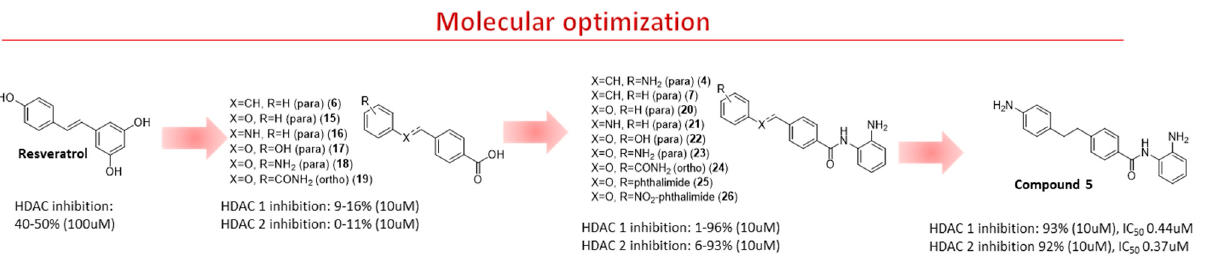
Figure 3. Molecular optimization to design novel RVT derivatives of HDAC-1 and HDAC–2 inhibitors.